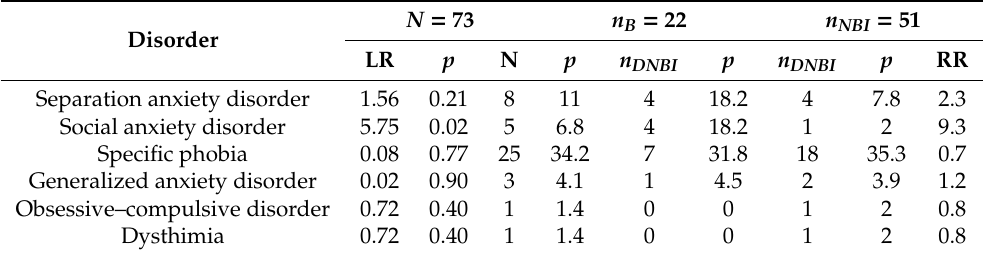
Table 1. Likelihood ratio for children with and without behavioral inhibition (BI) for each anxiety and mood